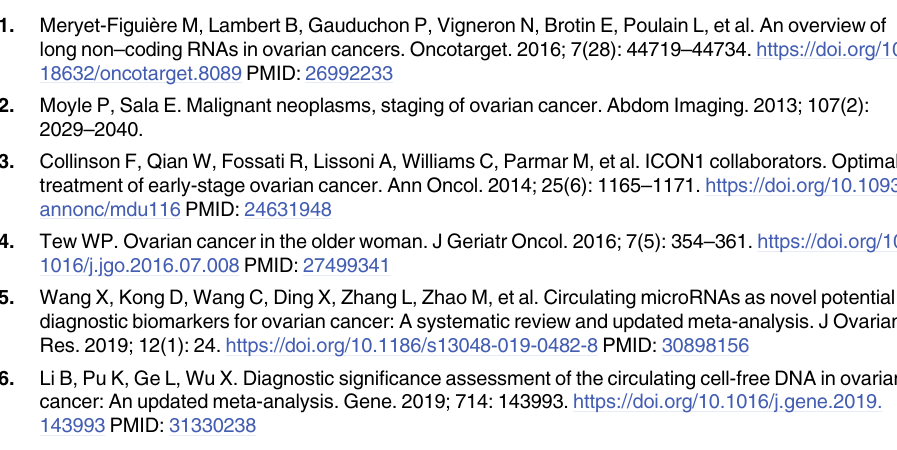
S1 Fig. Forest plots for studies on ctDNA/miRNAs used in the diagnosis of OC among rec- ords (outlier records were excluded). (a) Forest plots of sensitivity and specificity of ctDNA after excluding outlier record. (b) Forest plots of sensitivity and specificity of miRNAs after excluding outlier